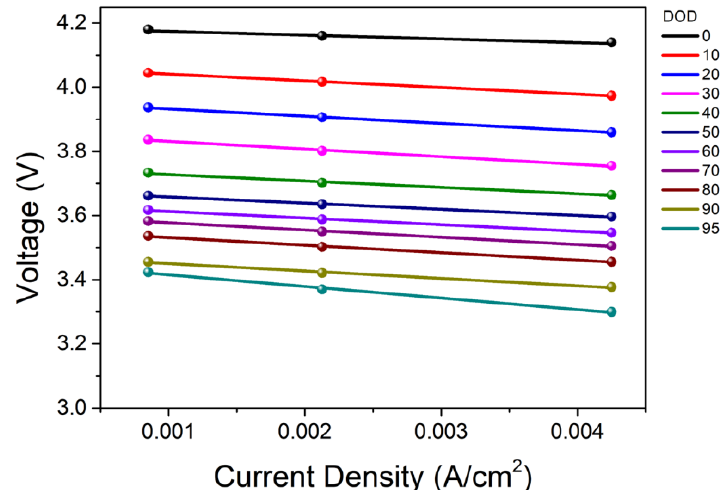
Figure 4. Strand voltage as a function of applied current density at various DOD levels during discharge.